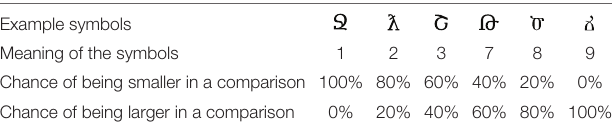
TABLE 1 | The chance of being smaller or larger in a comparison task when the symbols are presented with equal probability. Example